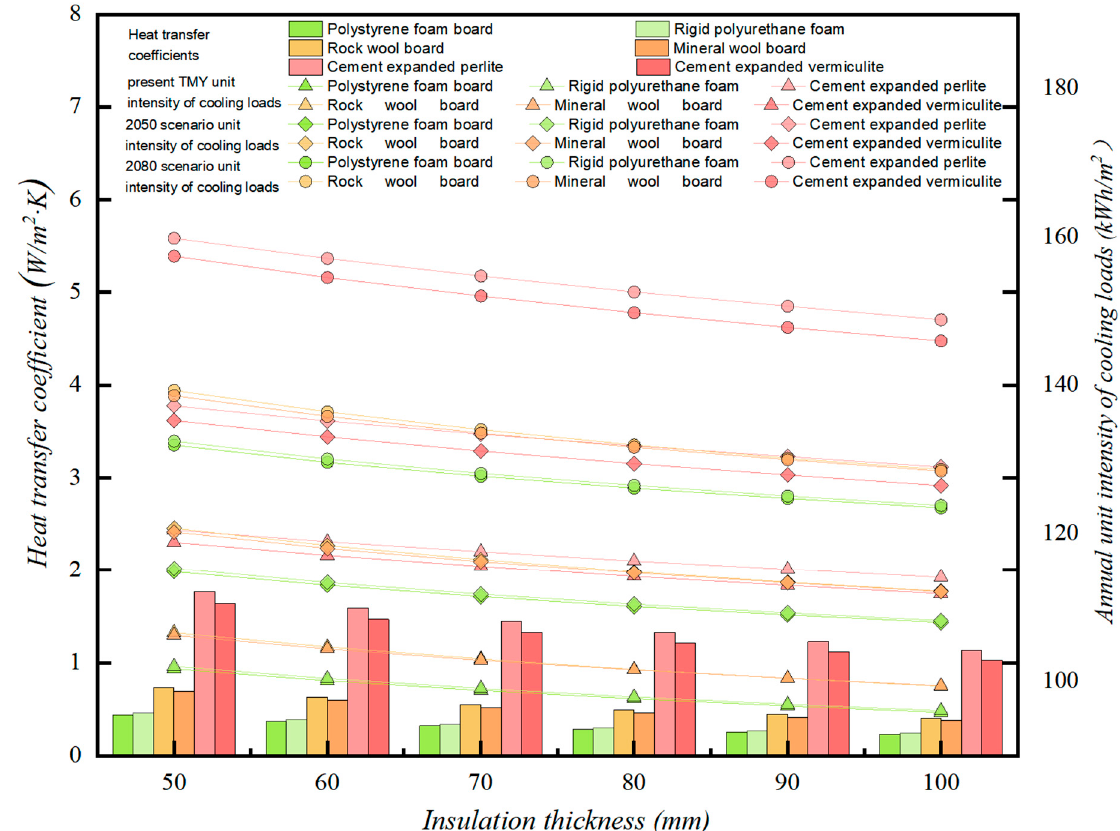
Figure 15. Annual unit intensity of cooling loads due to various wall insulation materials and thicknesses of present TMY and predicted future scenarios (2050 and 2080).